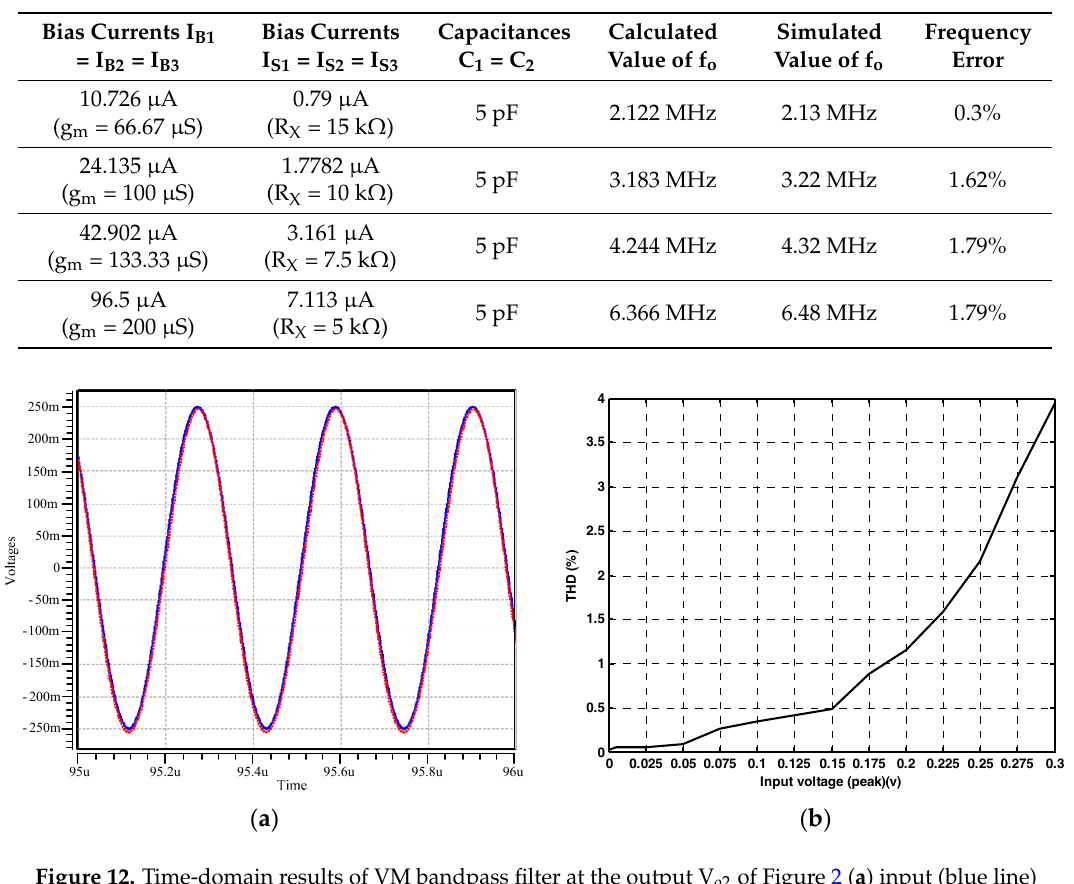
Table 8. Component values used to obtain a specified f o .